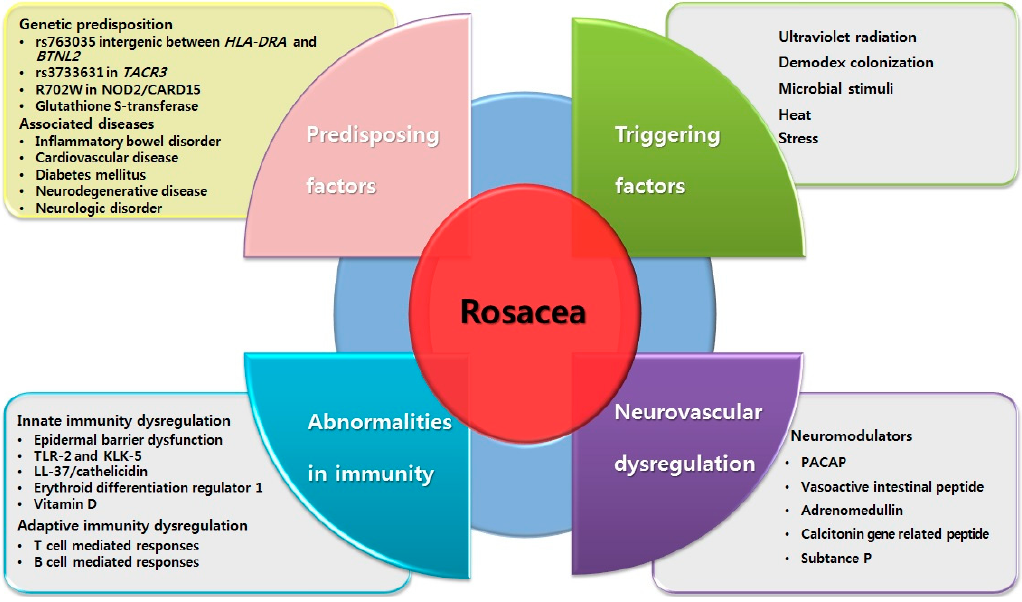
Figure 1. Schematic view of the factors known to contribute to the molecular mechanisms of rosacea.